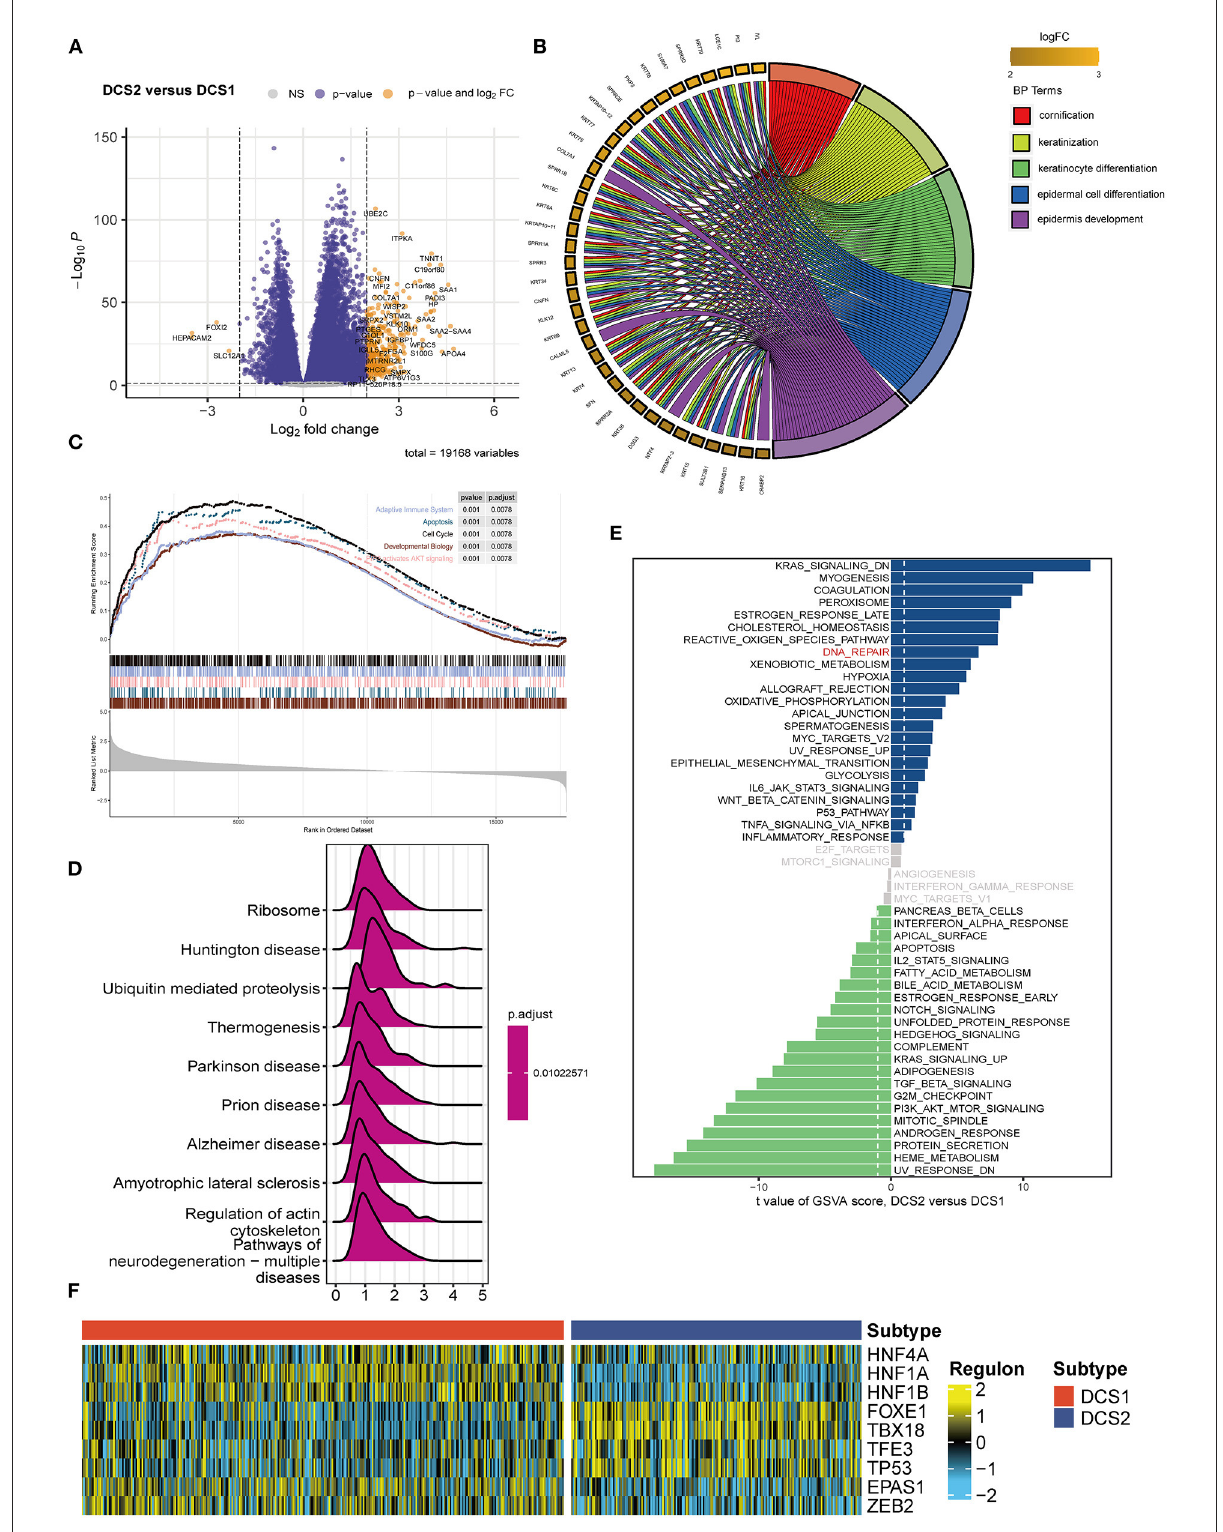
FIGURE2 Functional enrichment analysis of ccRCC subtypes. (A) Volcano plot showed DEGs. (B) BP enrichment analysis, (C) GSEA, (D) KEGG and (E) GSVA analysis between subtypes. (F) Different transcriptional factors’ regulon scores. Yellow represented activated expression of transcription factors. Blue represented repressed expression of transcription